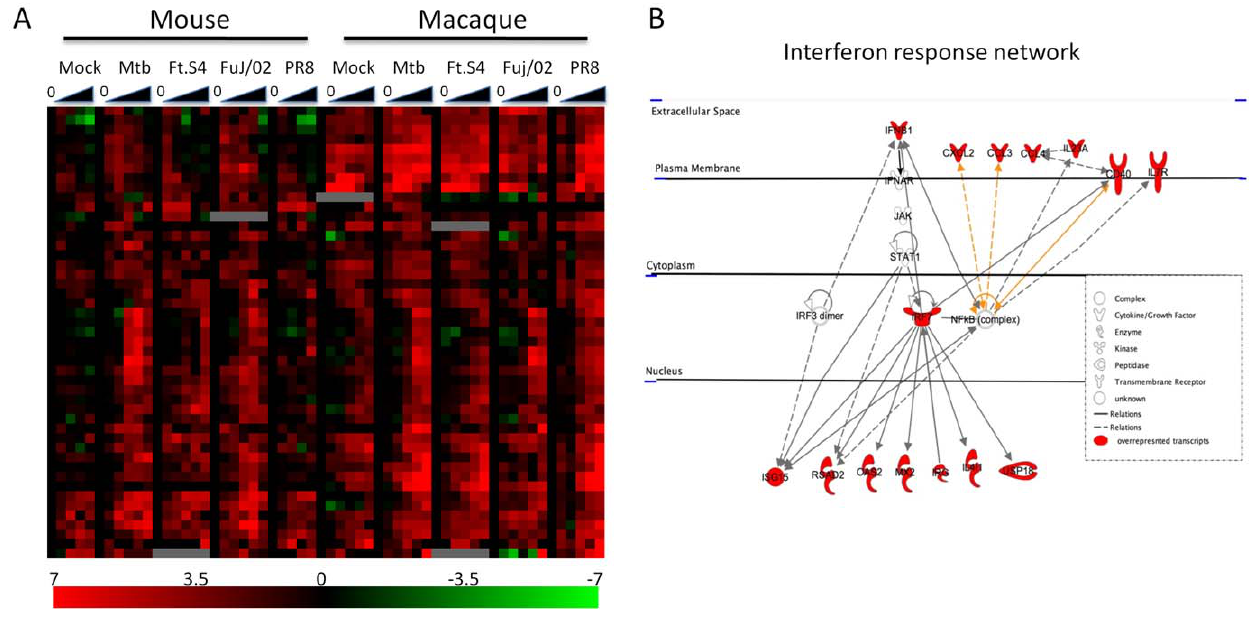
Figure 2. A core set of immune-related genes are upregulated in AM from both mouse and macaque. (A) Heatmap of the 47 DE genes that are upregulated in both mouse and macaque. The shows the time course of DE gene expression in AM exposed to medium (mock), Mtb (TB), Schu S4 (Ft.S4), influenza Fuj/02 or PR8. The time points analyzed were 0, 1, 2, 6, 12 and 24 hours post infection, and the values shown represent the median of all replicates at a particular time point. The scale represents fold change from time point 0 of 2 7– + 7 (log 2 ). (B) Pathway analysis of the 47 upregulated genes using Ingenuity software revealed significant overrepresentation of genes from the interferon response pathway, which is depicted here. doi:10.1371/journal.pone.0022401.g002 PLoS ONE |